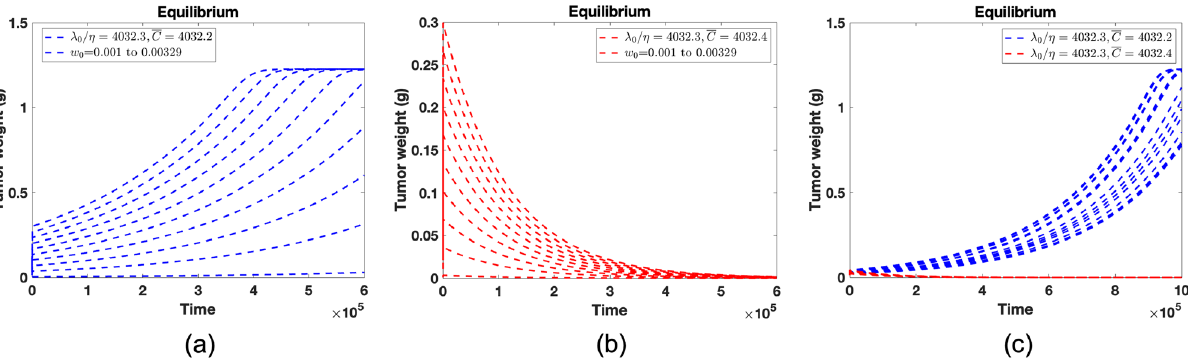
Figure 6. ( a ) (cid:31) 0 /η is 4032.3 which represents threshold. Constant drug infusions are given by 4032.2. w 0 ’s are variated from 0.001 to 0.00329 with the constant intervals. Drug infusion is 4032.2. Tumor has non- zero equilibrium. ( b ) Drug infusion rate is 4032.4 with the same initial tumor size in ( b ). Tumor has zero equilibrium. ( c ) Initial tumor size w 0 is fixed by 0.0121. The equilibrium points are changed according to the value of p . Ten points of p are chosen from uniform distribution [0, 1]. The equilibrium points are decreasing as p is increasing when C is less than (cid:31) 0 /η